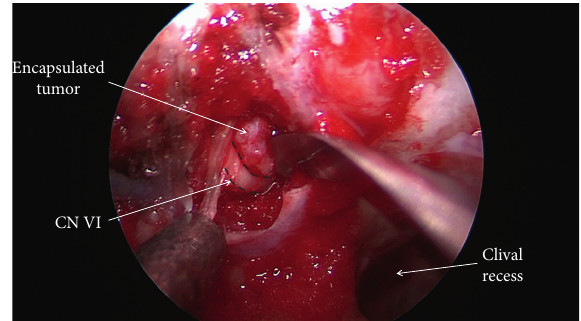
Figure 5: Visualization of the encapsulated epidermoid in a corridor superomedial to the abducens nerve.